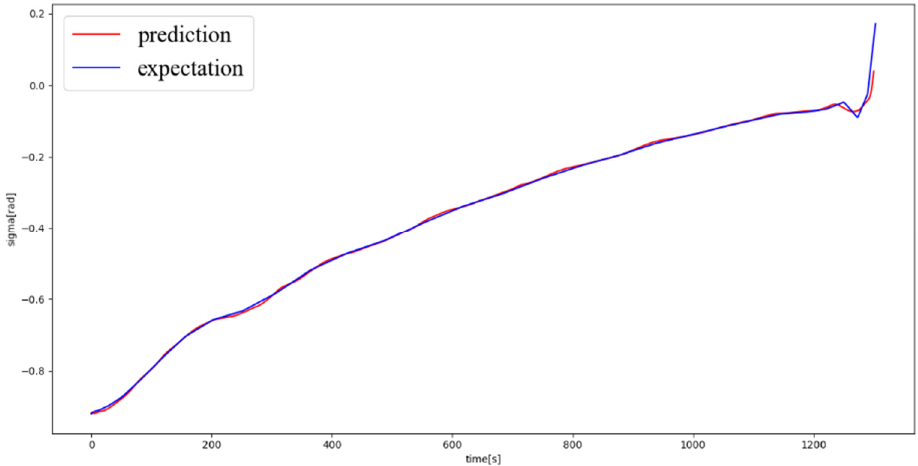
Figure 9. Comparison of the predicted and expected values of the inclination angle.